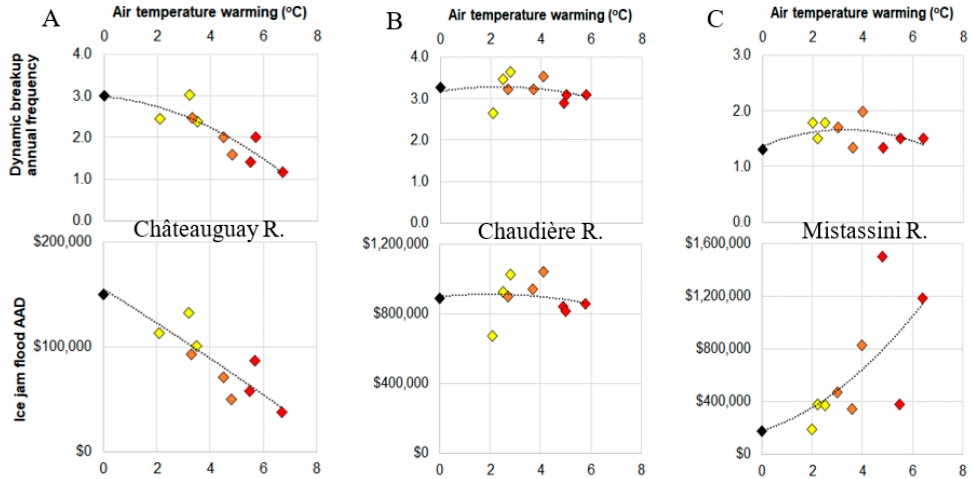
Figure 5. Frequency of dynamic breakup events (upper graph) and risk (AAD) associated with ice-jam floods (lower graph) expressed as a function of air temperature warming (historical conditions are presented in black and future climate scenarios in colors) for the ( A ) Châteauguay River, ( B ) Chaudière River, and ( C ) Mistassini River.